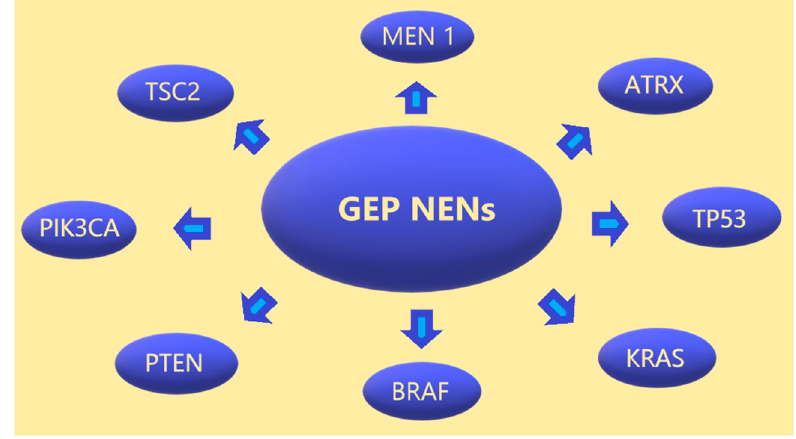
Figure 1. GEP NENs and their most common mutations.